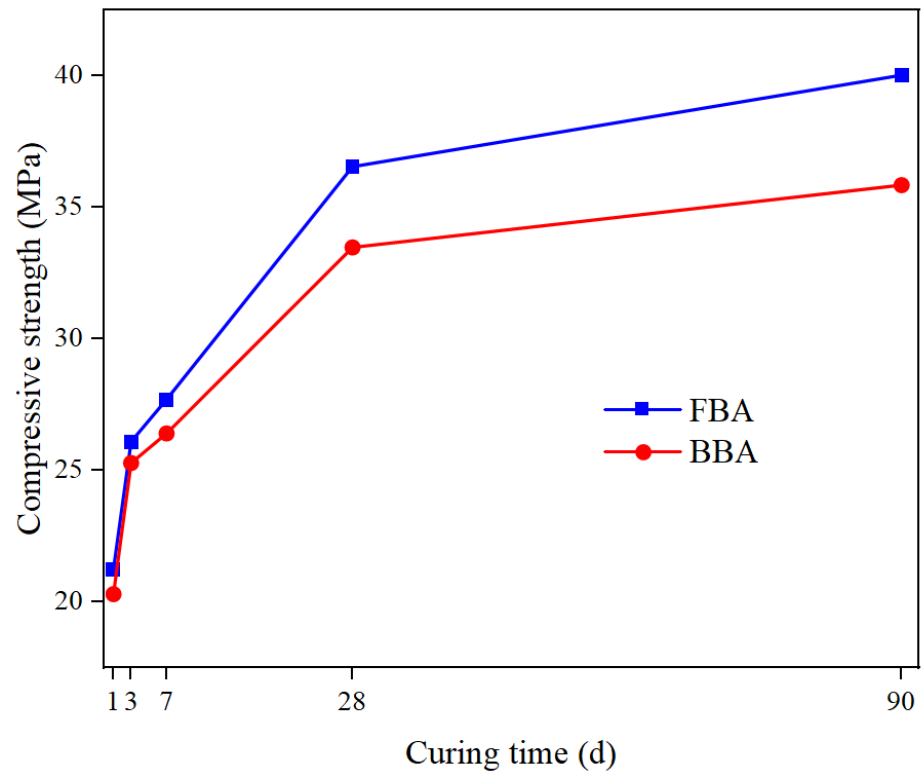
Figure 9. The effect of BA type on the compressive strength of MPC mortar (group 20 BA ‐ 80 MPC).